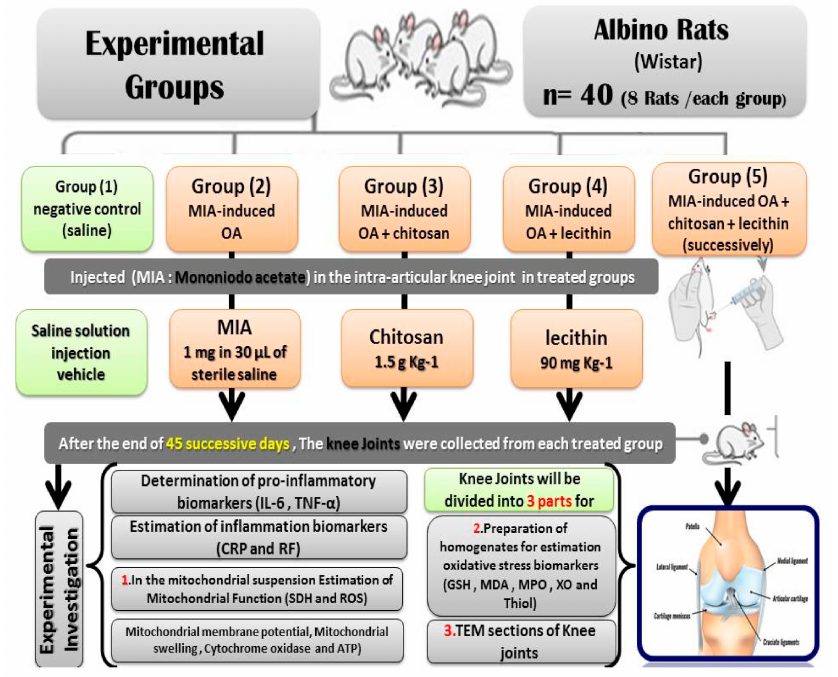
Figure 1. Experimental